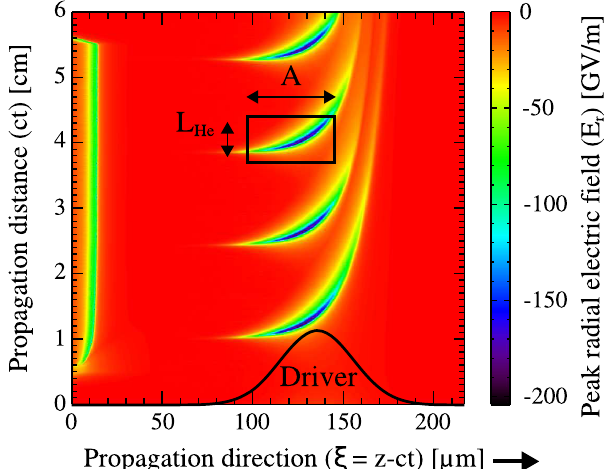
FIG. 5. Color map of the simulation peak radial electric field along the comoving direction ξ ¼ z − ct and propagation dis- tance, ct . Black solid line shows the beam profile normalized to background plasma density, n 0 . The black box delimits the region of ξ ∈ ½ 100 ; 150 (cid:2) μ m where the field reaches 63 GV = m for the interval L and where He is present, i.e., for ct ∈ ½ 3 . 7 ; 4 . 4 (cid:2) cm. He The driver propagates from left to right side of the